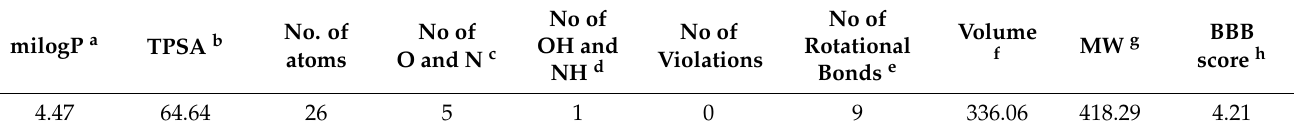
Table 1. Drug likeness and blood–brain barrier penetration studies of the newly synthesized com- pound 3